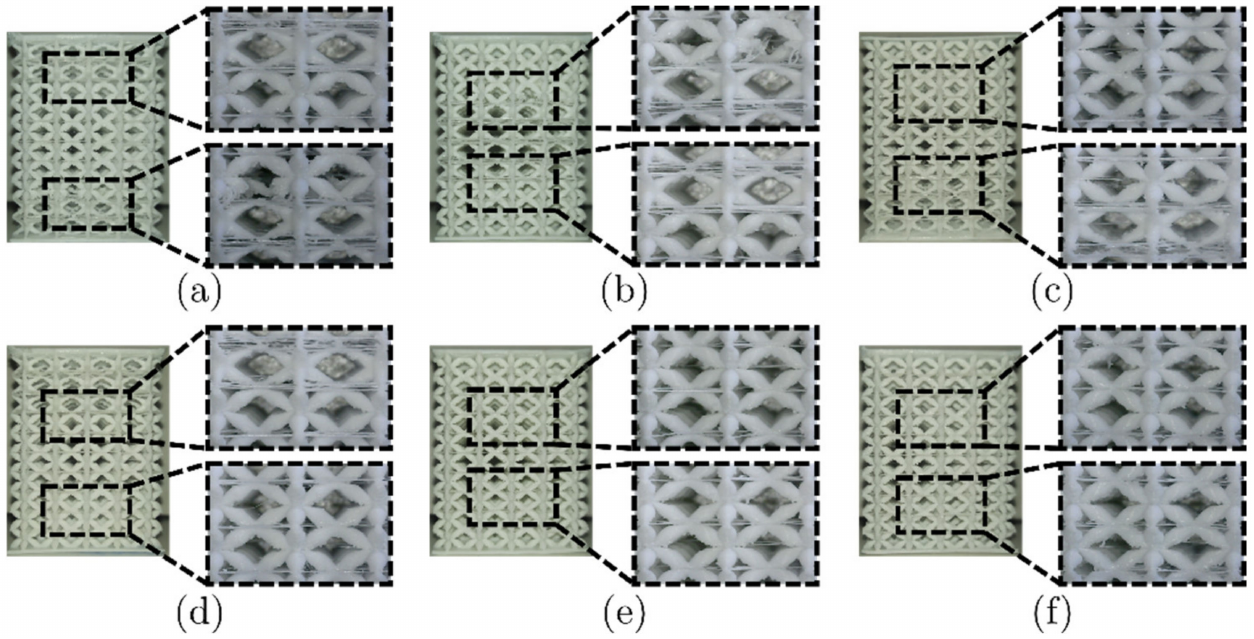
Figure 12. LLS printed via FFF: ( a ) HM-LM-HM, ( b ) LM-HM-LM, ( c ) HM-IM-LM, ( d ) LM-IM-HM, ( e ) LM-IM-LM and ( f )